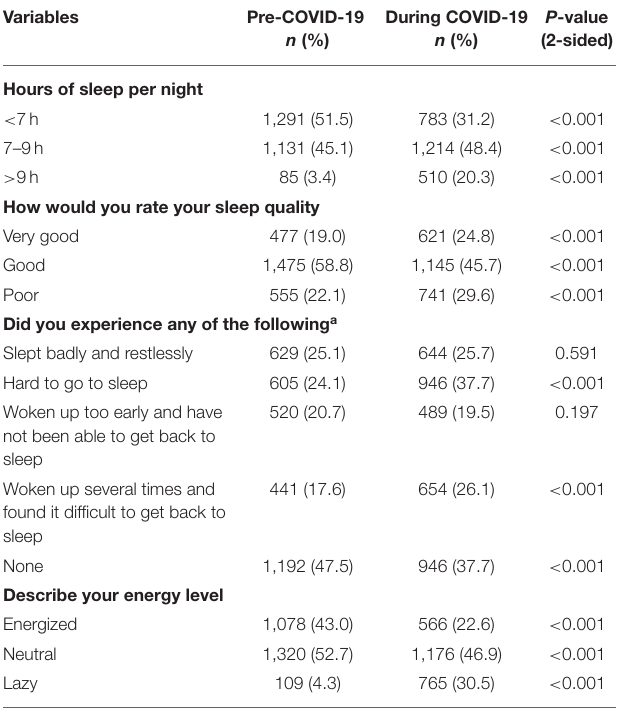
TABLE 7 | Sleep pre-and during COVID-19 pandemic ( n = 2,507).